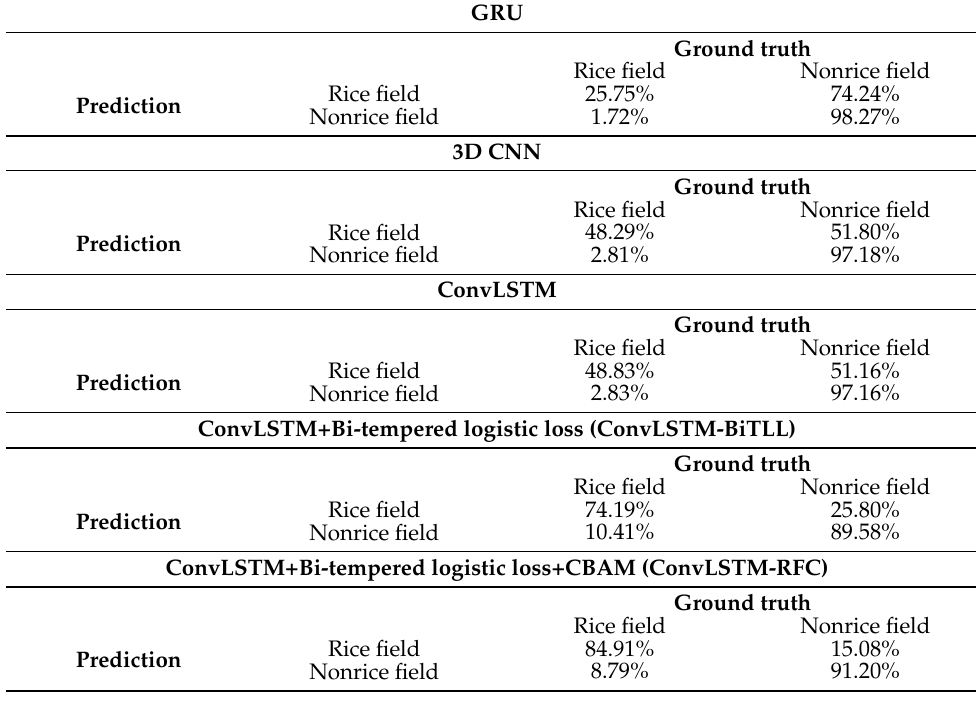
Table 3. Confusion matrices results of all models.